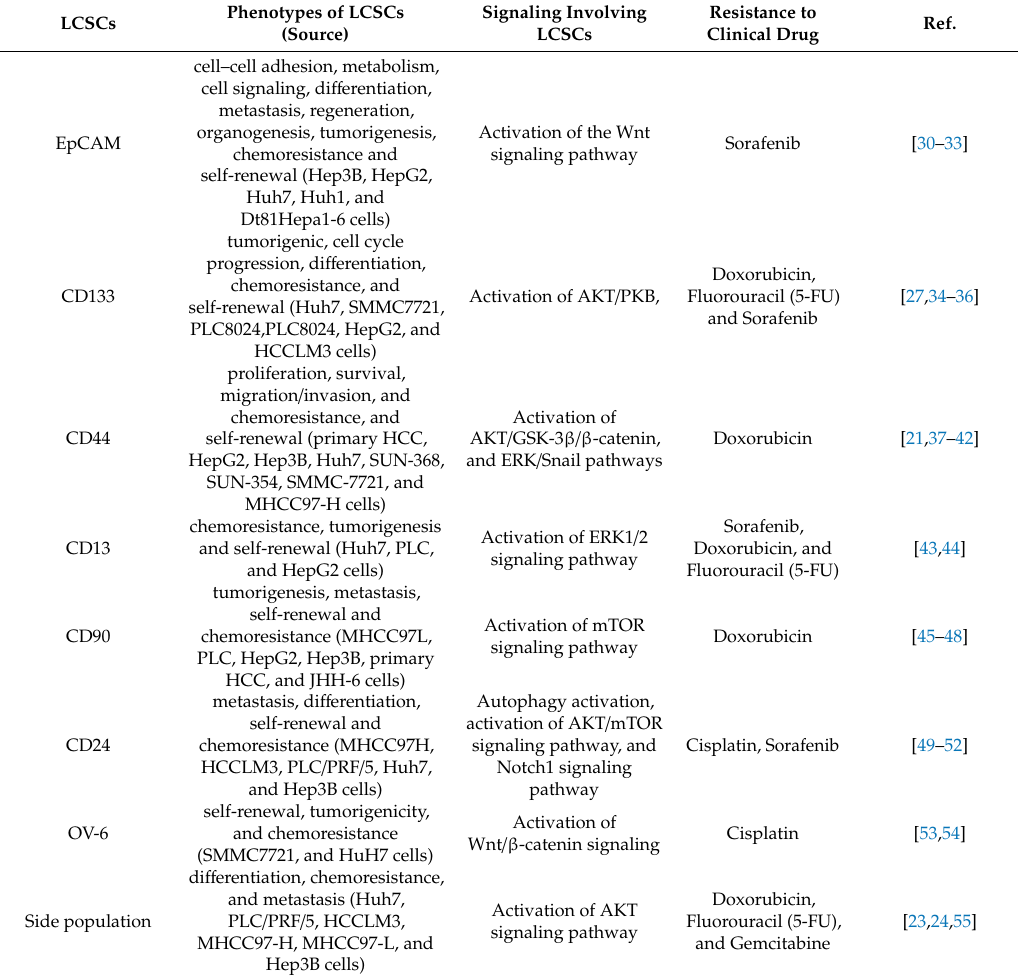
Table 1. Surface markers influencing the signaling pathways, phenotypes, and resistance to clinical drugs in LCSCs. Phenotypes of LCSCs Signaling Involving Resistance to LCSCs (Source) LCSCs Clinical Drug